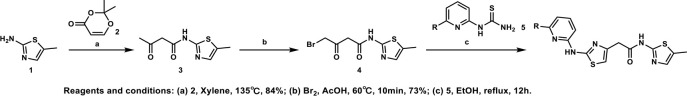
General procedure A.